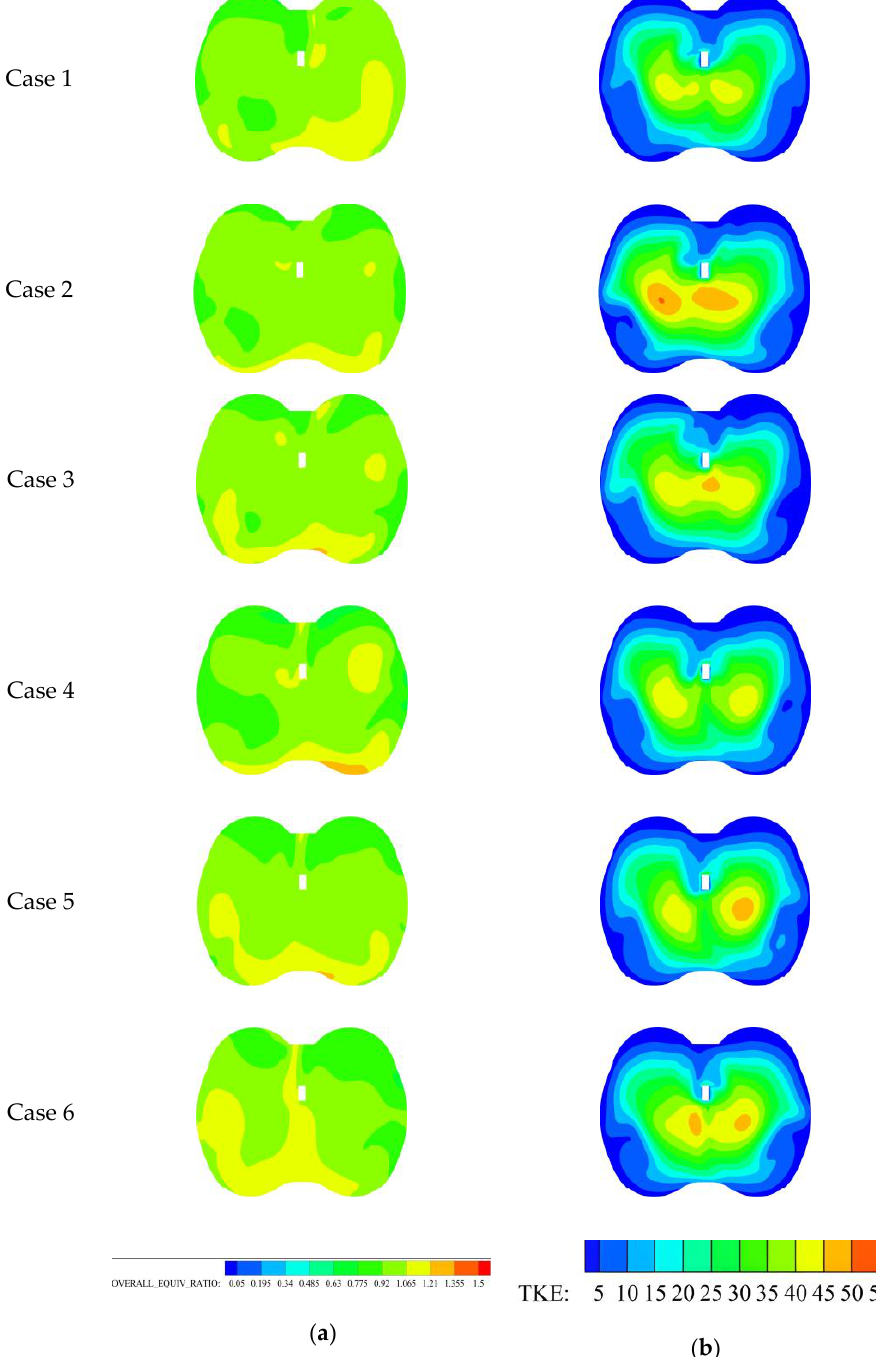
Figure 10. ( a ) Equivalence ratio and ( b ) TKE (m 2 /s 2 ) at ignition time in different water injection cases (CR = 10.3, ignition time = − 14 degCA). Water evaporates in the intake port and lowers the intake air temperature, so the density of the intake air will increase, but at the same time, water vapor will occupy part of the intake air volume. If the benefit of increased intake density is greater than the effect of water vapor occupying the intake volume, then the amount of intake air entering the cylinder will increase, and vice versa. As can be seen in Figure 11, PWI technology in- creases the amount of air entering the cylinder, indicating a more pronounced effect of increased air intake density. The equivalence ratio of case 4 was the smallest, indicating that this case had the most air mass entering the cylinder. An equivalence ratio of less than 1 ensures complete combustion of the fuel theoretically, but it also has the potential to increase the combustion temperature and thus the NO X emissions.